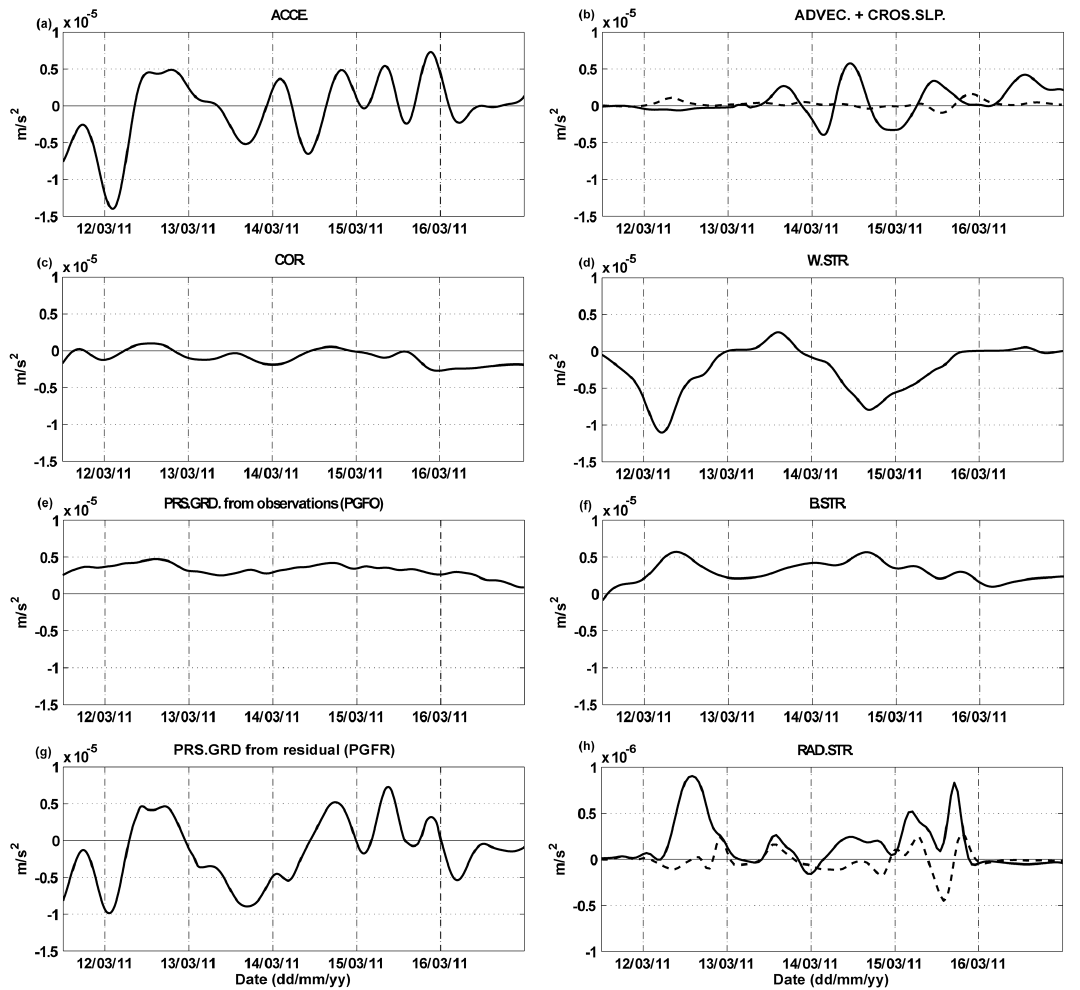
Figure 4. Estimates for the along-shelf momentum terms at 25m. Left-hand-side terms of Eq. (1): (a) acceleration terms (ACCE. δv/δt) , (b) advective (solid line, ADVEC., δv 2 /δy + δ(vu)/δx ) and cross-slope (dashed line, CROS.SLP., ( uv/H) δH/δx ) terms estimated from the currents at the neighboring ADCP locations and (c) Coriolis term (COR., f u) . Right-hand-side terms of Eq. (1): (d) wind stress term (W.STR., τ ys /ρH) , (e) pressure-gradient force from observations (PGFO term, gδη/δy ), (f) bottom stress term (B.STR., τ yb /ρH) , (g) pressure-gradient force from residual (PGFR) and (h) radiation stress term (RAD.ST., (1 /ρH)δS xy /δx solid line, and (1 /ρH ) δS yy /δy dashed line). Notice the change in the vertical scale in panel (h) . The data used for estimating the momentum terms have been low-pass filtered, with a cutoff period of 12h. The date indicates